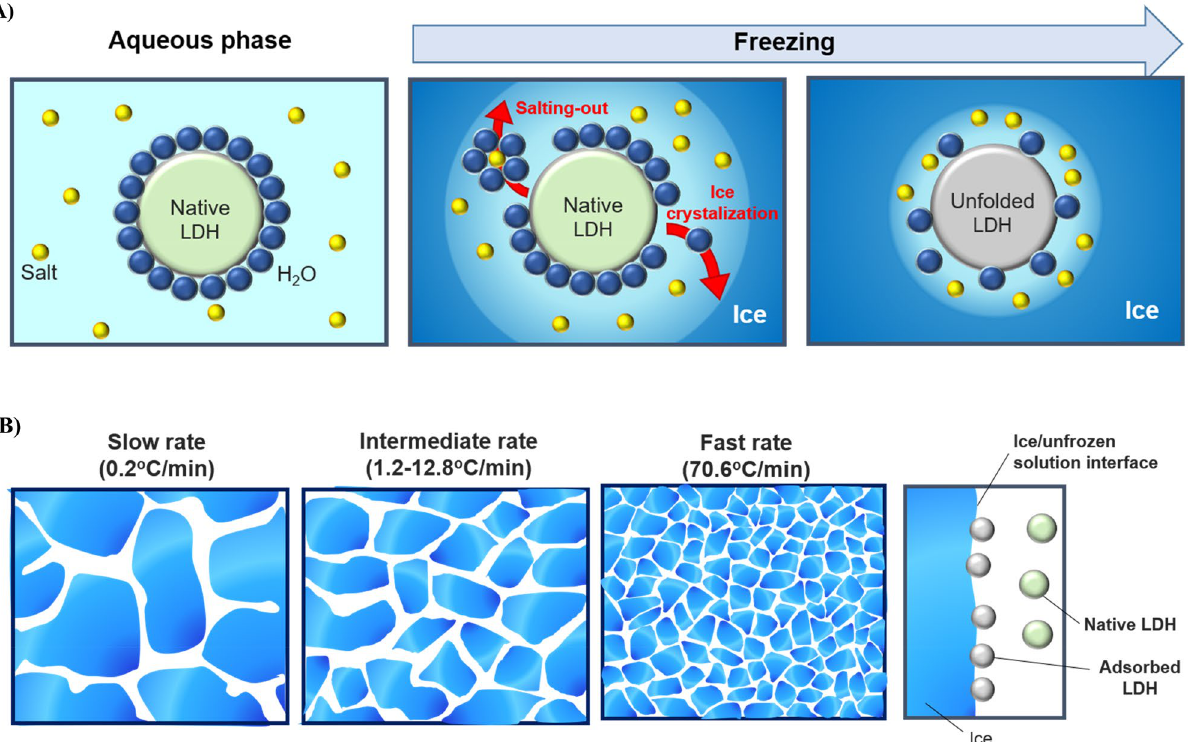
Figure 3. Schematic illustration of the mechanisms of enzyme destabilization by fast freezing. ( A ) Increased dehydration at the enzyme surface. ( B ) Formation of an ice/unfrozen solution